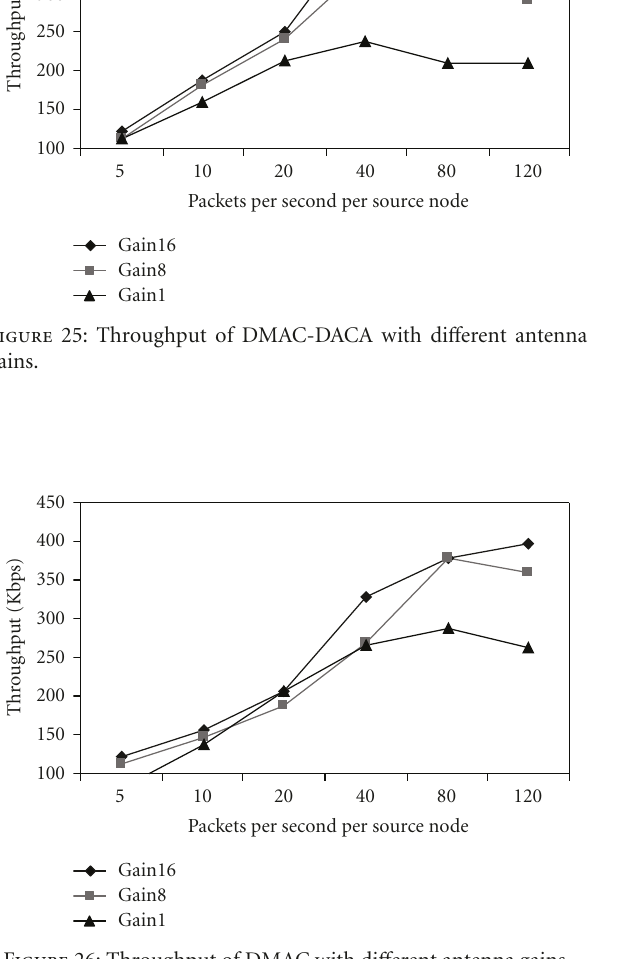
Figure 26: Throughput of DMAC with di ff erent antenna gains.